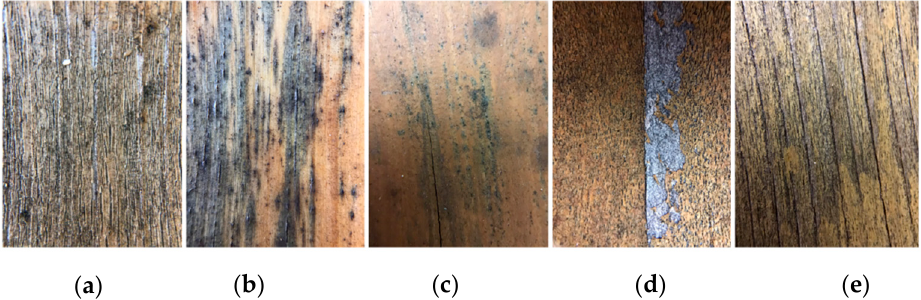
Figure 1. Types of coating failure after natural weathering exposure. ( a ) Several types of micro-checks and micro-cracks; ( b ) irregular micro-checks; ( c ) long line checks; ( d ) combination of checks, cracks, flaking, and erosion; ( e ) advanced coating erosion.